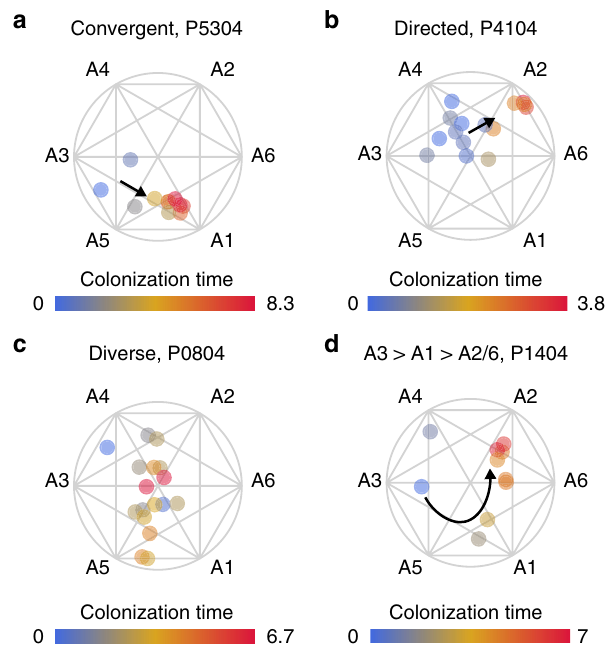
Fig. 6 Evolutionary trajectories guided by different adaptation objectives. We present four different trajectories showing modes of evolution found in multiple patients: a Convergent evolution driven primarily by changes of a single phenotypic trait (decreased cipro fl oxacin sensitivity). b Directed diversity with early/naive isolates showing a population moving in a broad and diverse plane from naive archetypes towards evolved archetypes. c General diversity where the population has no clear evolutionary trajectory. d A special case of convergent evolution with one outlier isolate (isolate 96 of DK12) but an otherwise clear trajectory fi rst towards cipro fl oxacin resistance and afterwards a gain in adhesive